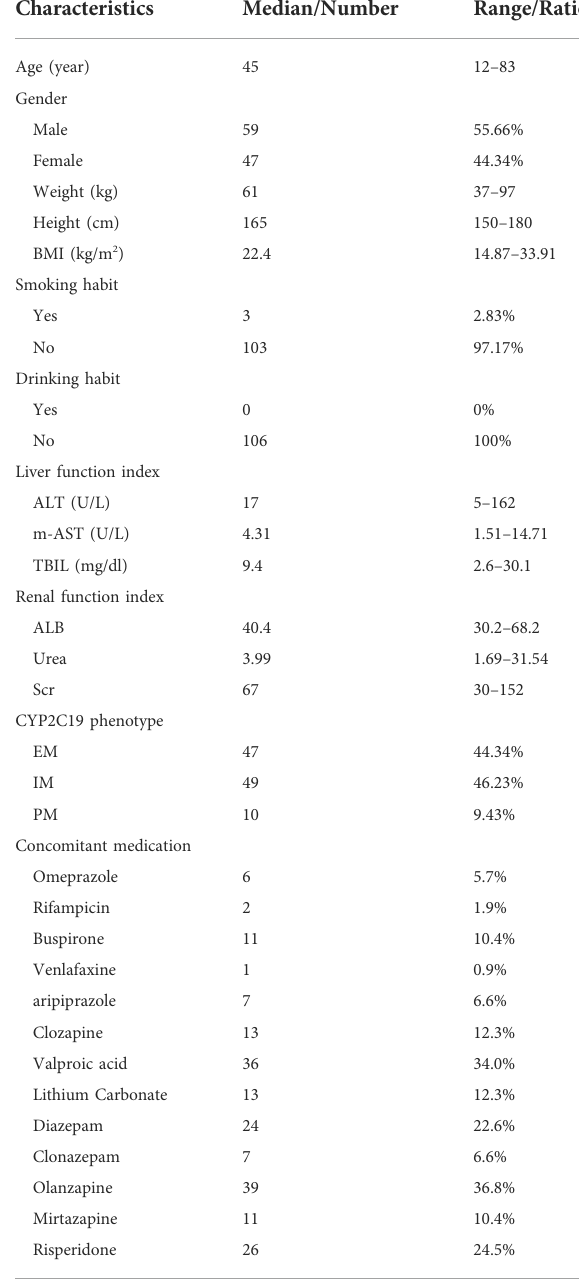
TABLE 1 Demographic data and patients